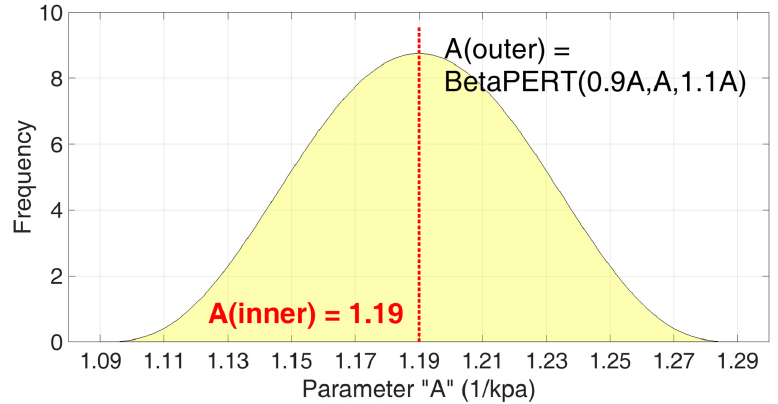
Appl. Sci. 2022 , 12 , 6206 Figure 6. Inner and outer parameter settings for the stochastic 1D model. Figure 6. Inner and outer parameter settings for the stochastic 1D model.